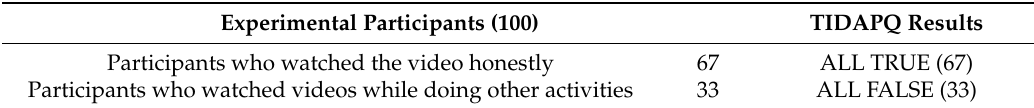
Table 3. Participants of TIDAPQ Model Verification.